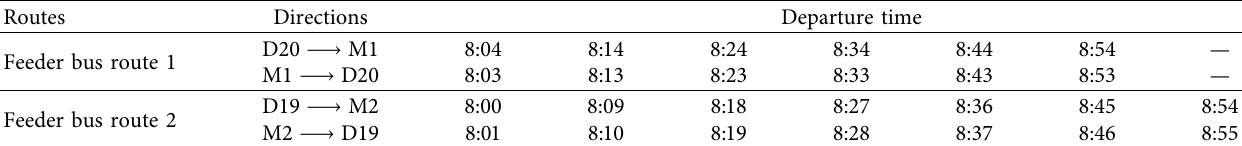
Table 7: Timetable of feeder bus.